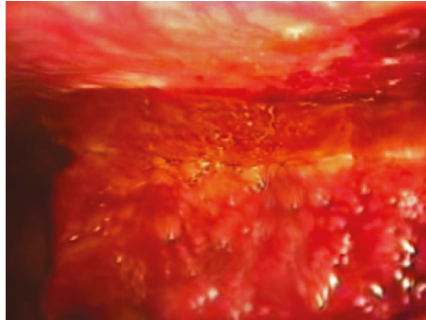
Figure 9: Omentum – hemorrhage and fat necrosis.